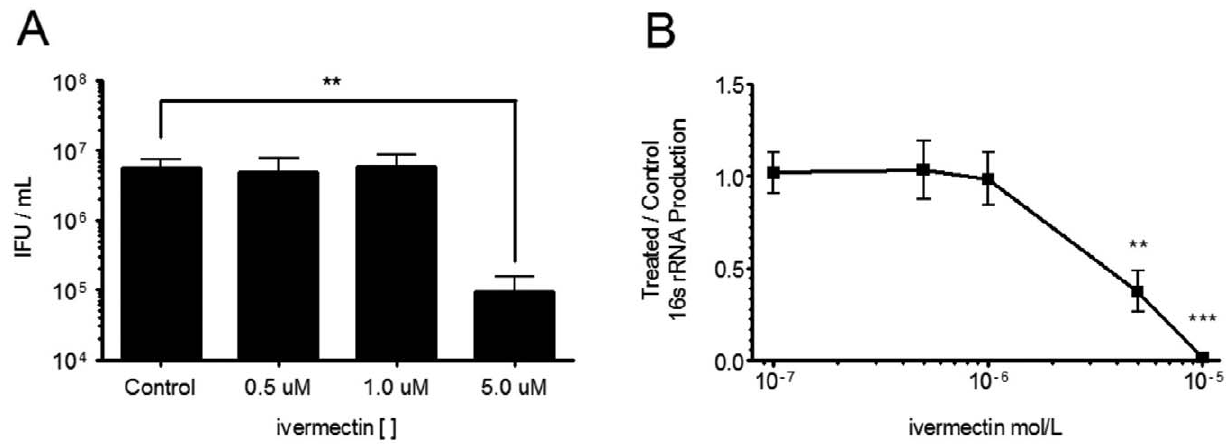
Figure 1. Ivermectin inhibits chlamydial infection of epithelial cells. (A) HeLa cells were infected with C. trachomatis serovar L2 at an MOI of 1, followed by treatment with ivermectin at the indicated concentrations at 1 hour post infection (hpi). Samples were harvested at 24 hpi for quantification of reinfectious yield (IFU/ml) on new HeLa cell monolayers utilizing fluorescent microscopy and anti- C. trachomatis antibodies. The values show means plus standard deviation of three independent experiments. (n=3,**, P=0.0059). (B) Total RNA was harvested at 24 hpi for quantification of chlamydial 16s rRNA. The values shown are relative to control values for each experiment, and are means and standard deviations of 3 independent experiments (n=3, **, P=0.0034, ***, P , 0.001, compared to 100 nM condition). Two-tailed unpaired t tests were performed using GraphPad Prism version 5.0b for Mac.